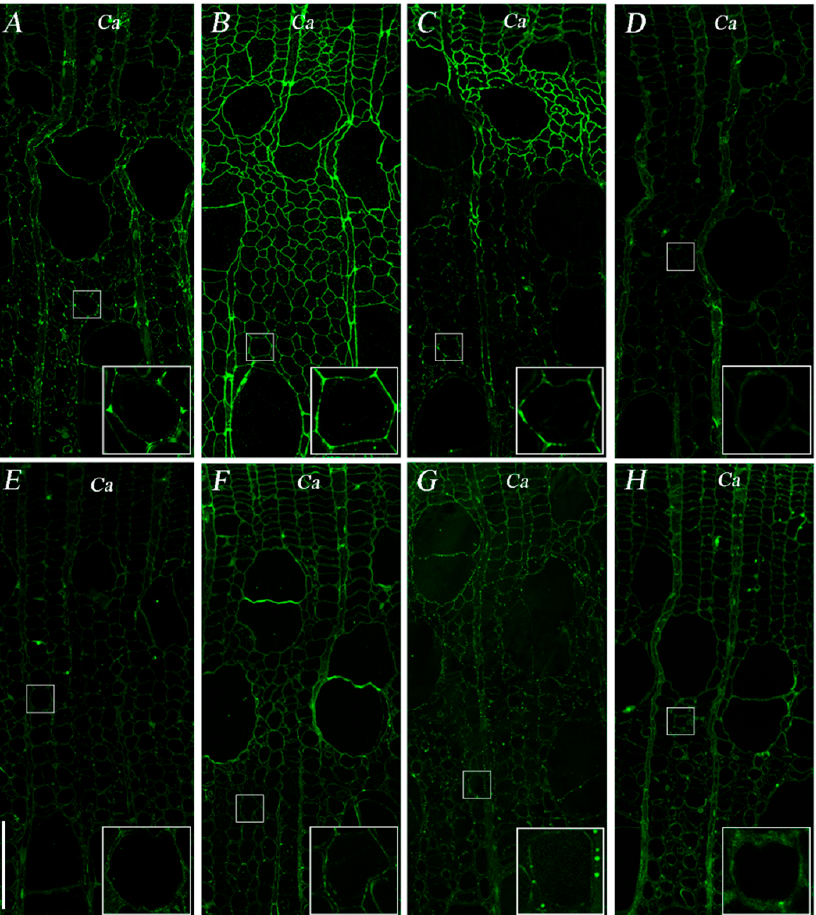
Figure 5. Pectin immune localization in developing xylem of P. euramericana ‘Zhonglin46’ ( A – D ) and P. euramericana ‘Neva’ ( E – H ). ( A , E ) JIM5-labeled unesterified pectin. ( B , F ) JIM7-labeled esterified pectin. ( C , G ) LM5-labeled RG-I pectin. ( D , H ) LM6-labeled RG-I pectin. An enlarged view of a fiber cell is shown in the white box. Ca: cambium. Scale bar = 100 µm.